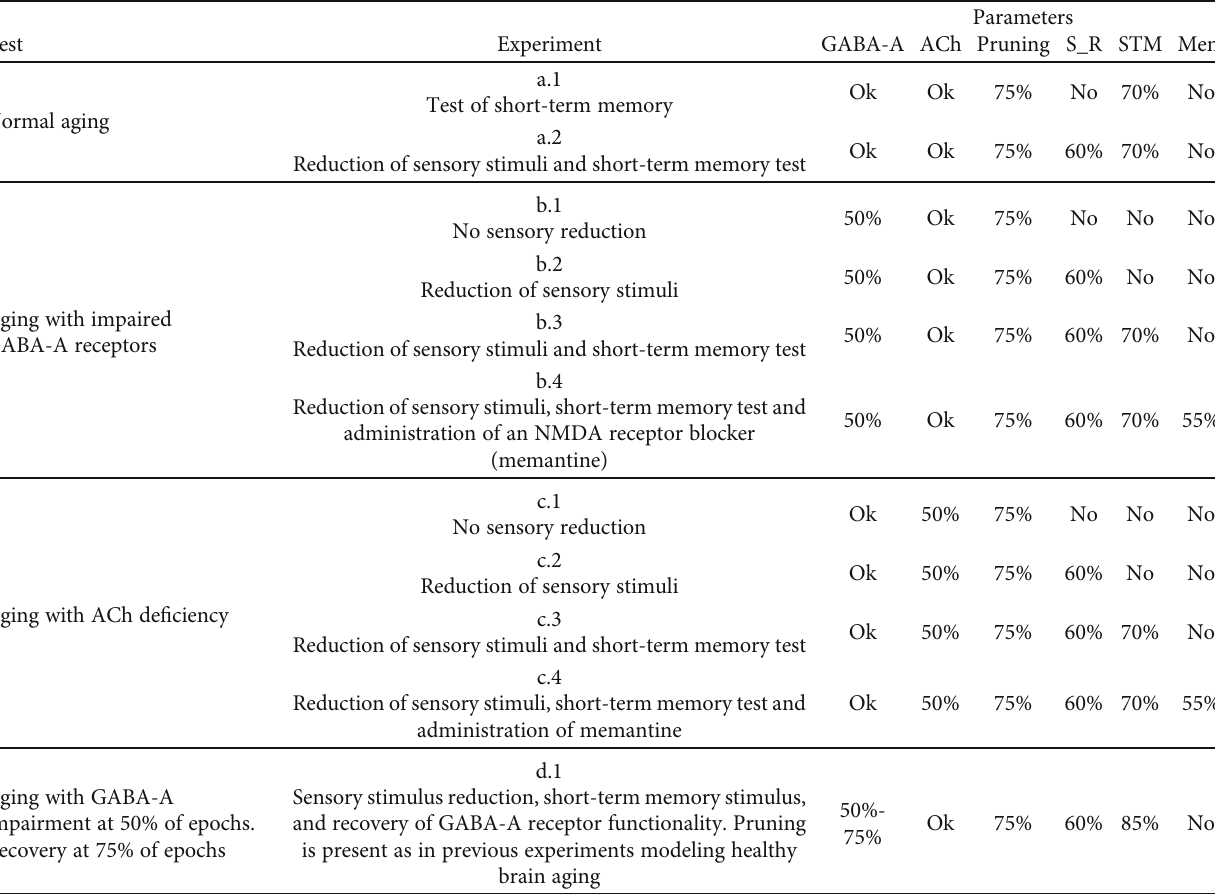
Table 1: Description of the performed tests and their corresponding parameters. Abbreviations: (a) GABA-A: this column shows the percentage of epochs in which GABA-A de fi cit initiates. (b) ACh: this column exhibits the percentage of epochs in which ACh de fi cit begins. (c) Pruning: the values indicate the percentage of epochs in which pruning initiates. (d) S_R: the values below this title indicate the percentage of epochs in which stimulus reduction starts. (e) STM: the values below this title indicate the percentage of epochs in which the experiment of short-term memory initiates. (f) Mem: when memantine treatment (i.e., an NMDA blocker simulation) is applied, the numeric value shows the percentage of epochs in which memantine treatment